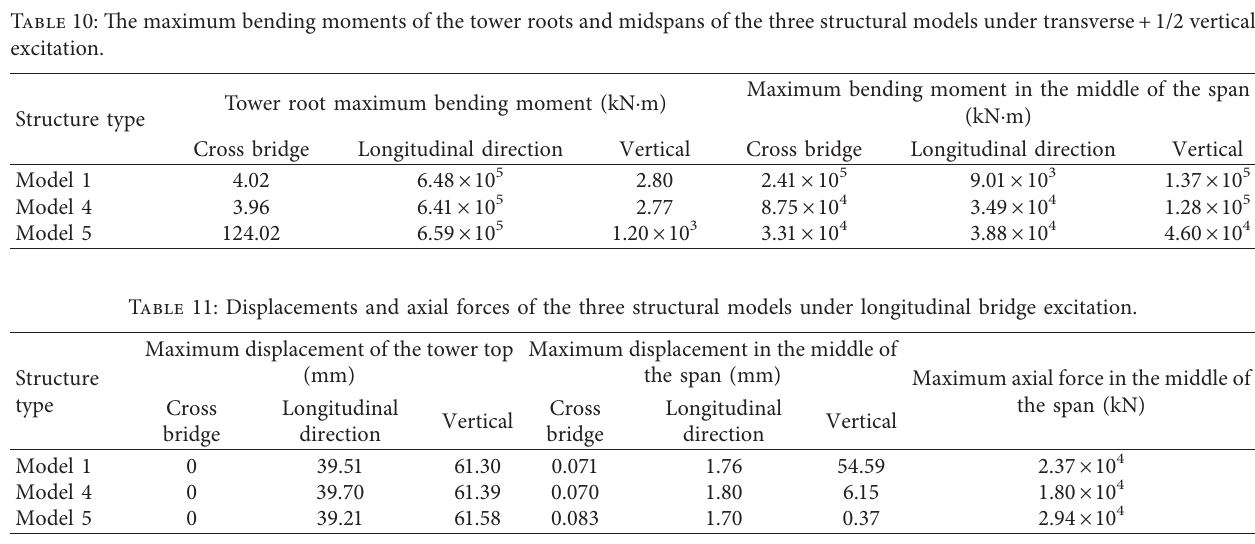
Table 12: Displacements and axial forces of the three structural models under longitudinal bridge direction +1/2 vertical excitation. Structure